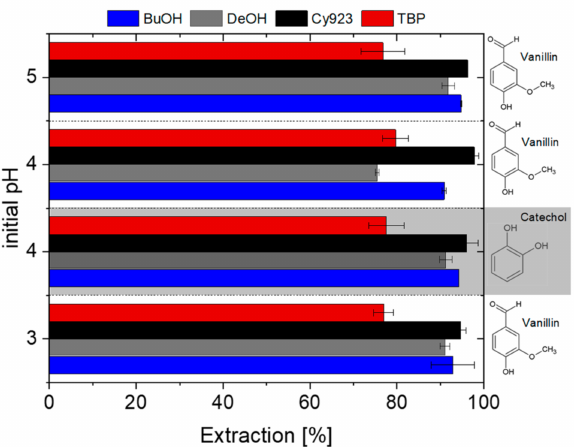
Figure 2. Effect of different initial pH values and extractants on the vanillin and catechol extraction.